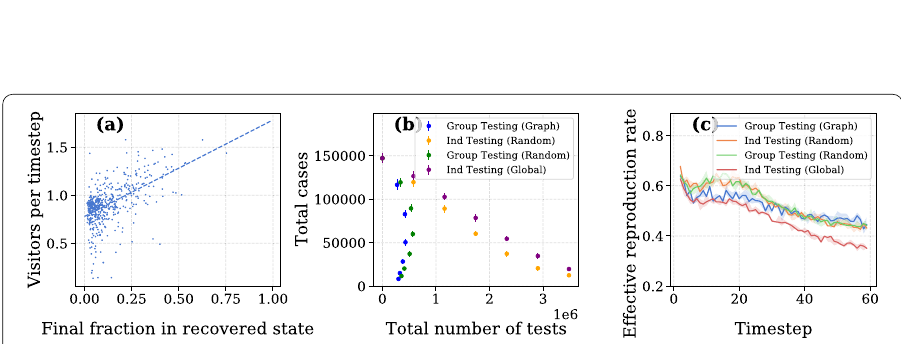
Fig. 6 a Relationship between a CBG’s mobility and total case count ( q = 0.15 and δ = 0.2 ). Visitors per timestep is normalized by the size of the CBG. b Each testing strategy’s total number of tests and resulting case count. c Effective reproduction rate R ( t ) when q = 0.2 and δ = 0.3